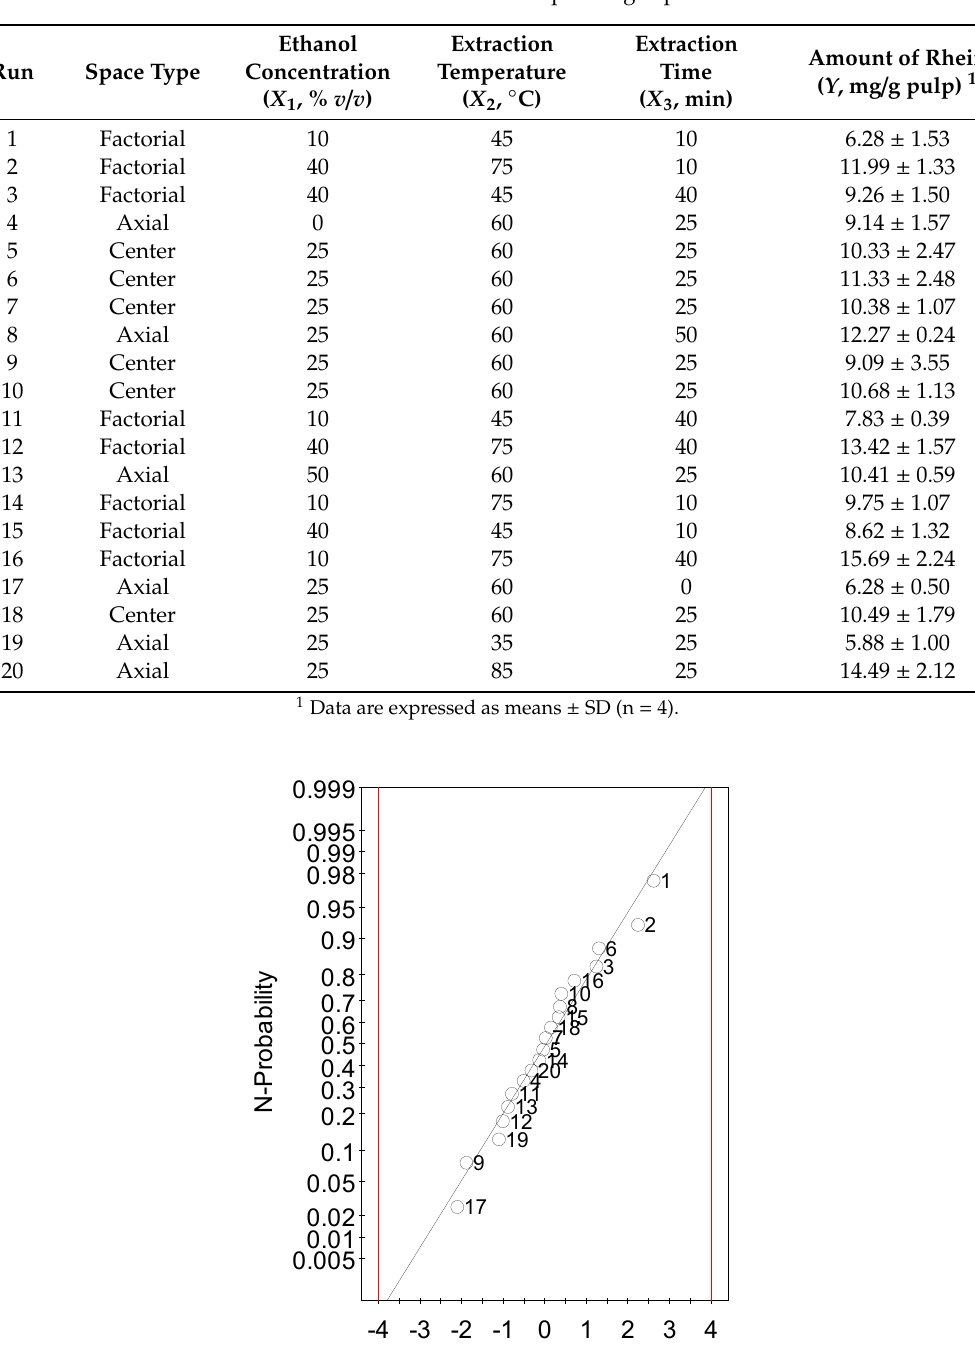
Table 1. Amount of rhein and the corresponding experimental runs.